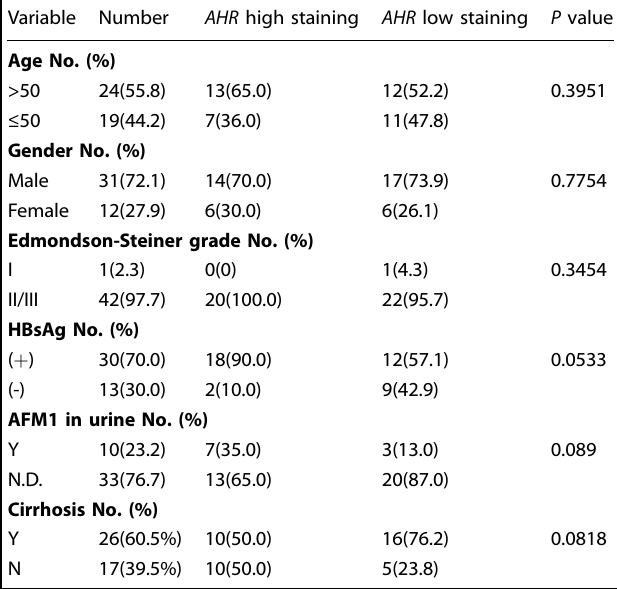
Table 1. AHR staining and clinicopathological characteristics of hepatocellular carcinoma